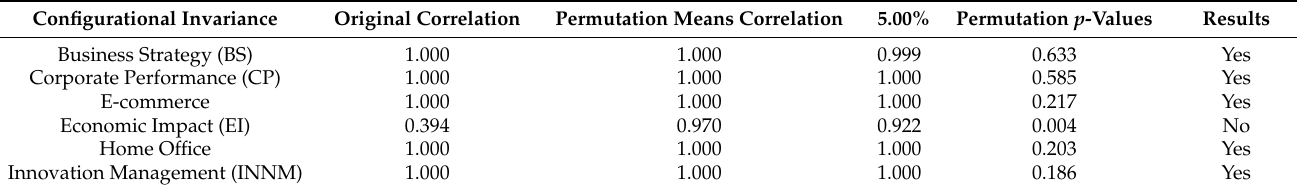
Table 6. Configurational invariance.